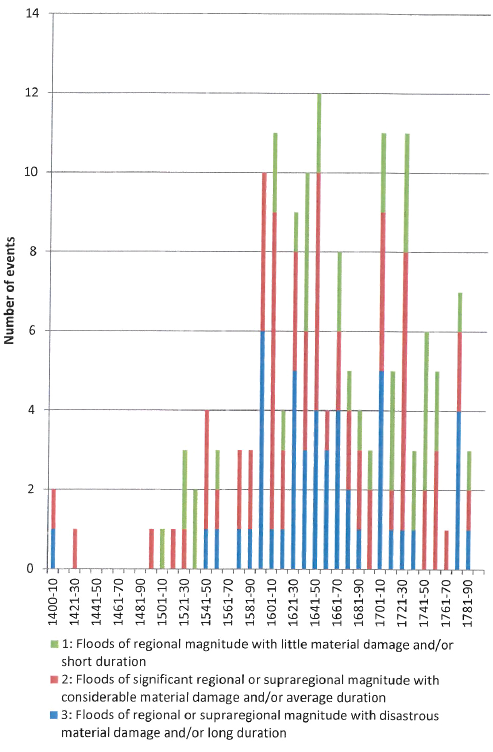
Figure 3. Documentary evidence of floods and extreme rainfall events in Sweden, 1400–1800, with levels of